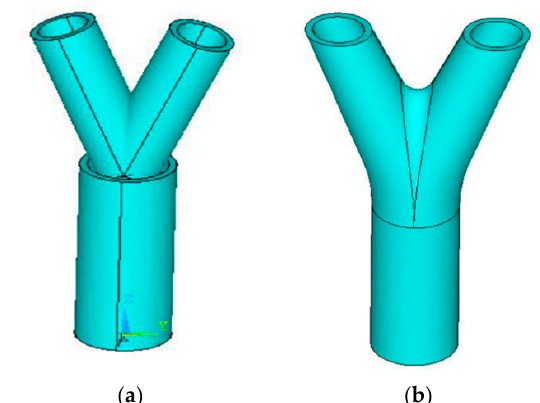
Figure 9. Model creation, ( a ) by ANSYS; ( b ) by SolidWorks.